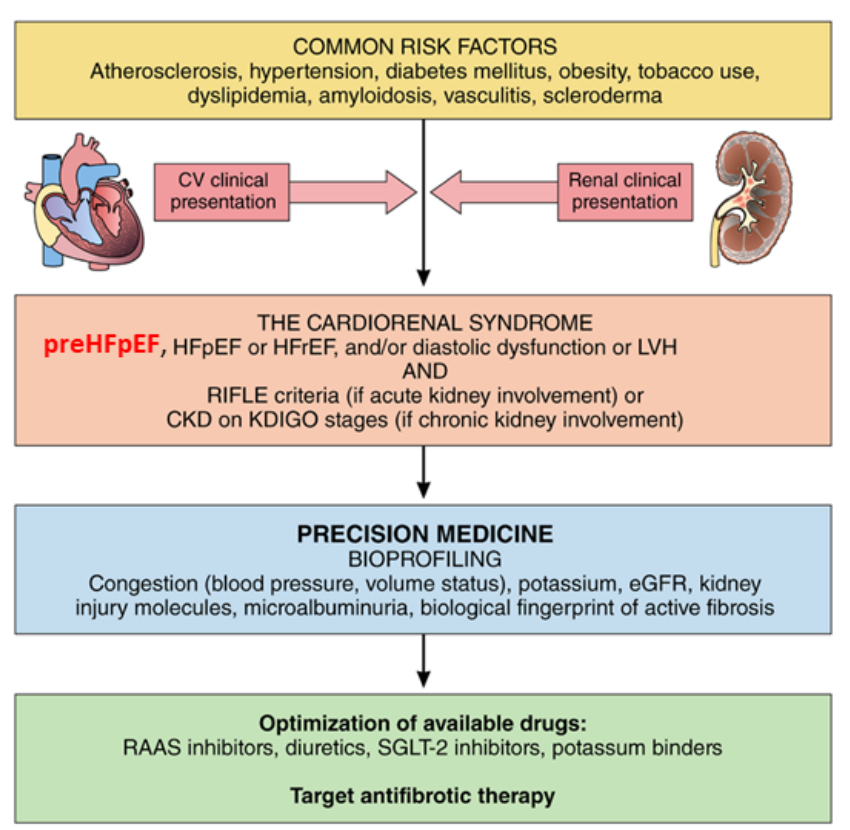
Figure 4. Revisited cardiorenal syndrome (modified with permission from Ref. 69). This figure depicts a proposed new paradigm in which common risk factors lead to cardiorenal syndrome that may have either a cardiovascular (CV) or a renal clinical presentation. Bioprofiling with clinical and biomarker information will enable precision medicine optimized to a specific profile. CKD indicates chronic kidney disease. HFpEF, heart failure with preserved ejection fraction; HFrEF, heart failure with reduced ejection fraction; KDIGO, Kidney Disease Improving Global Outcomes; LVH, left ventricular hypertrophy; and RIFLE (Risk, Injury, Failure, Loss, End-Stage).